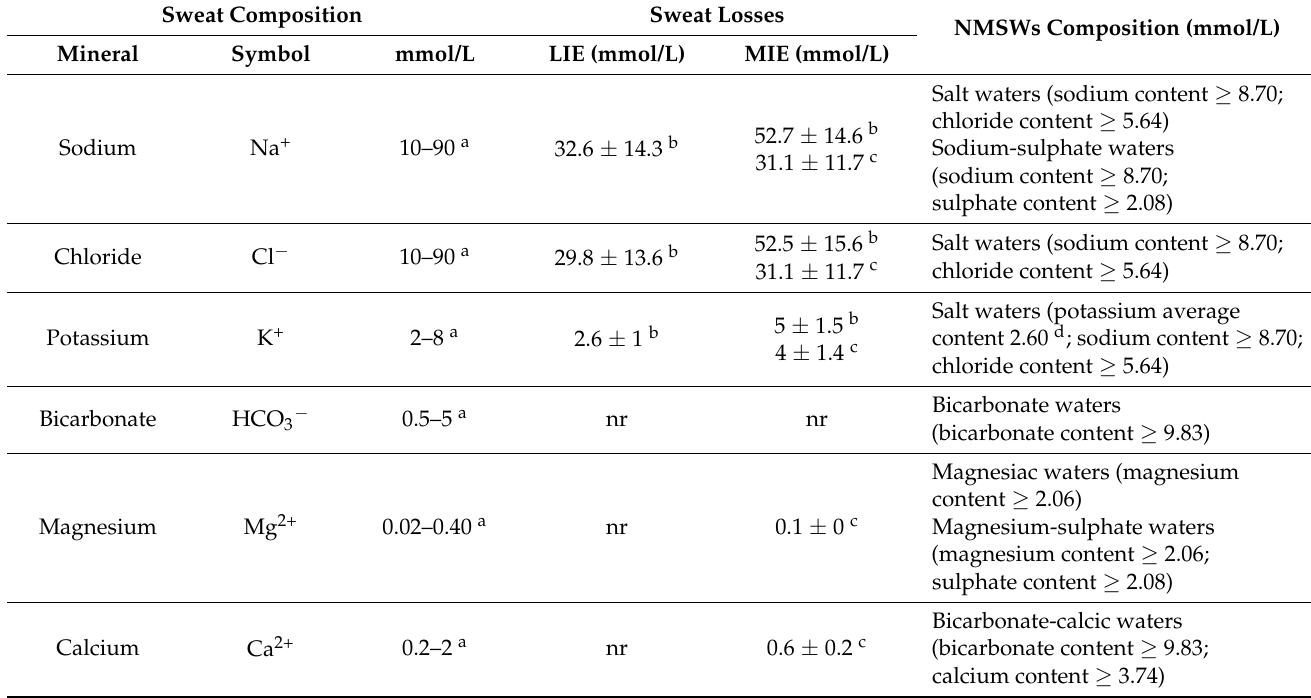
Table 2. Comparisons between sweat electrolytes composition and losses during low- (LIE) and moderate-intensity (MIE) exercises and composition of medium- and high-mineralized natural mineral spring waters